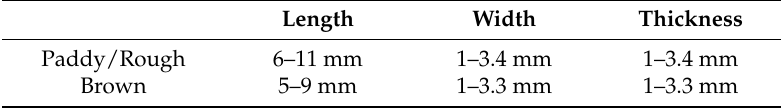
Table 1. Size dimensions of paddy and brown rice used.